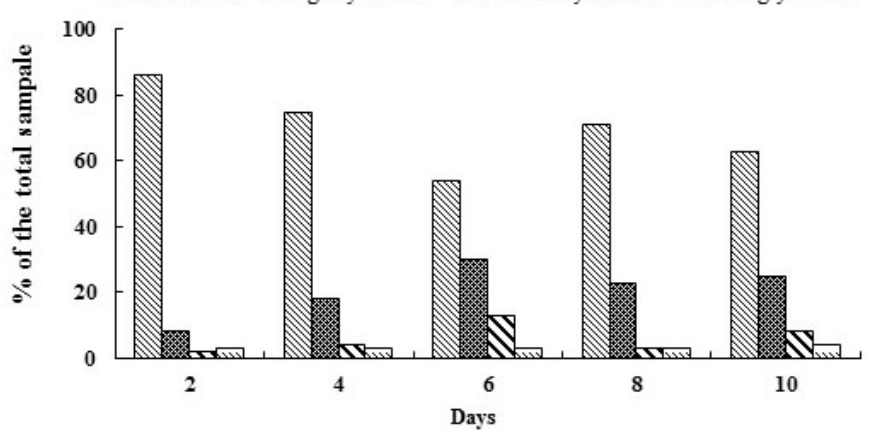
Figure 5. Distribution of soil salinity classes during the irrigation